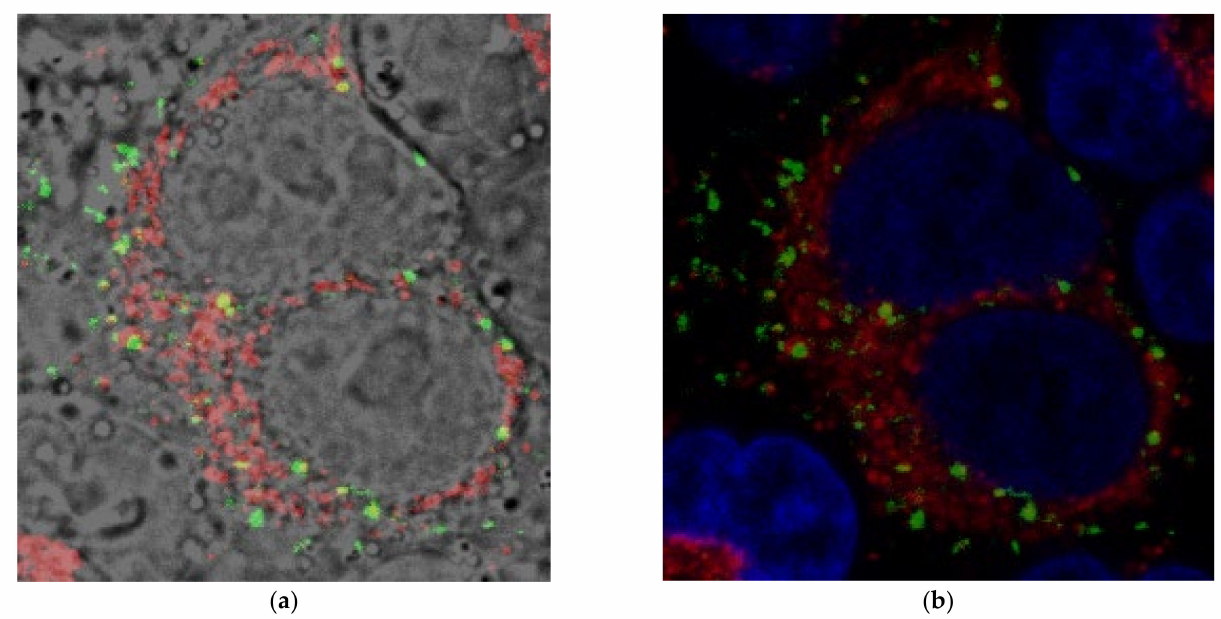
Figure 5. Colocalization of 4c (green, 1 µ M) with MitoTracker ® (red) and Hoechst 33342 (blue, nucleus) in H460 cells observed by confocal microscopy (cells were treated with 1 µ M of the compound for 60 min at 37 ◦ C and incubated with a 100 nM MitoTracker ® and 20 mM Hoechst 33342 solution for 20 min at 37 ◦ C): ( a ) overlay of brightfield with 4c (green) and MitoTracker ® (red); ( b ) overlay of 4c (green) with Hoechst 33342 (blue, nucleus) and MitoTracker ®